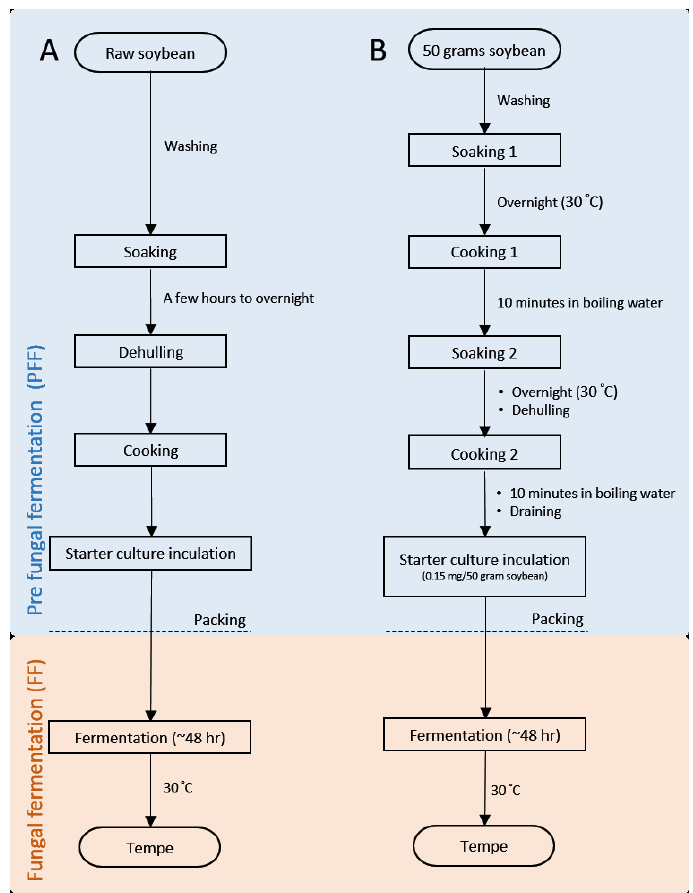
Figure 1. The workflow of tempe production process. ( A ) The general steps of tempe making procedure and ( B ) the methods of tempe making used in this research. The steps marked in blue area and orange area herein will be referred as to pre fungal fermentation stage (PFF) and fungal fermentation (FF) consecutively.